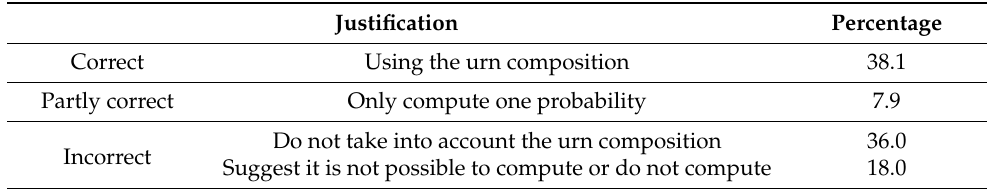
Table 3. Responses given to Task 1b.